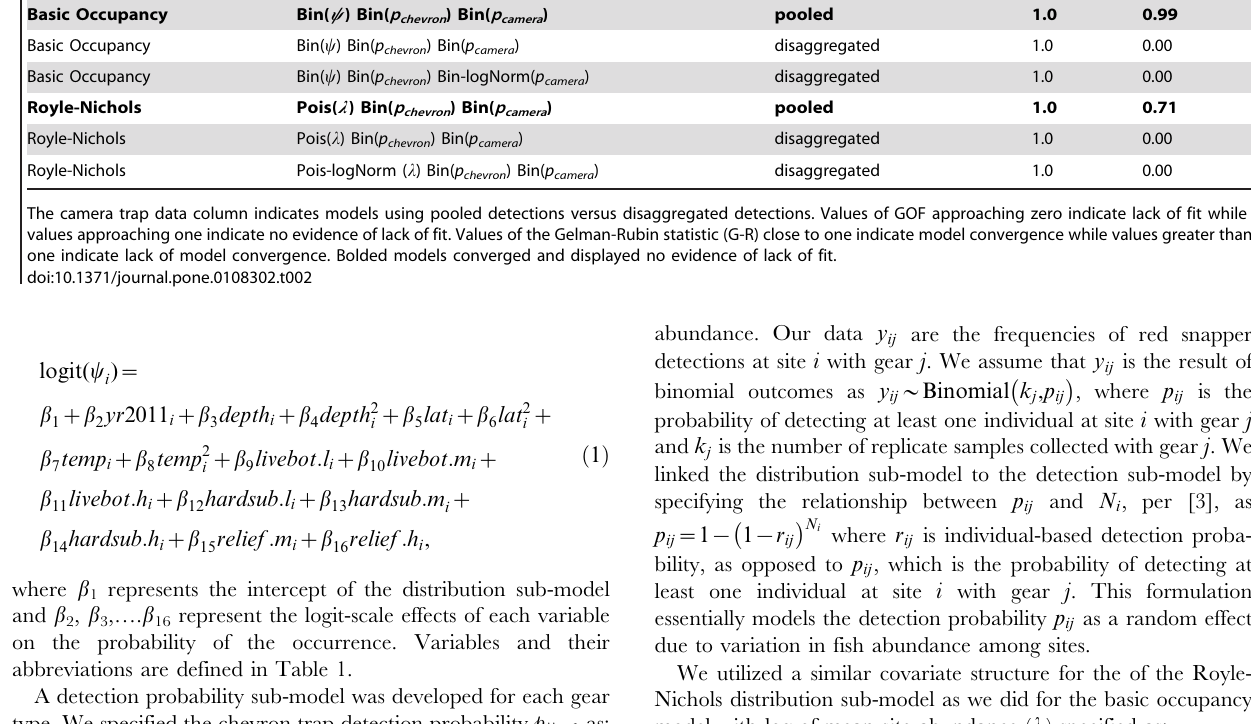
Model Type Model